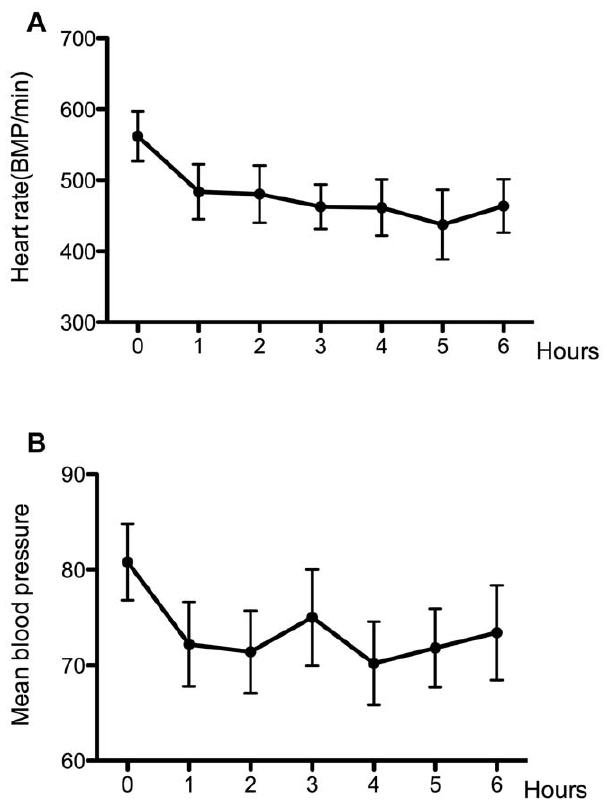
Figure 3. Six-hour isoflurane anesthesia had no significant effects on blood pressure and heart rate. Separate animals were used to monitor blood pressure and heart rate. During the six-hour isoflurane exposure, animals maintained stable heart rates (A) and stable blood pressure (B).